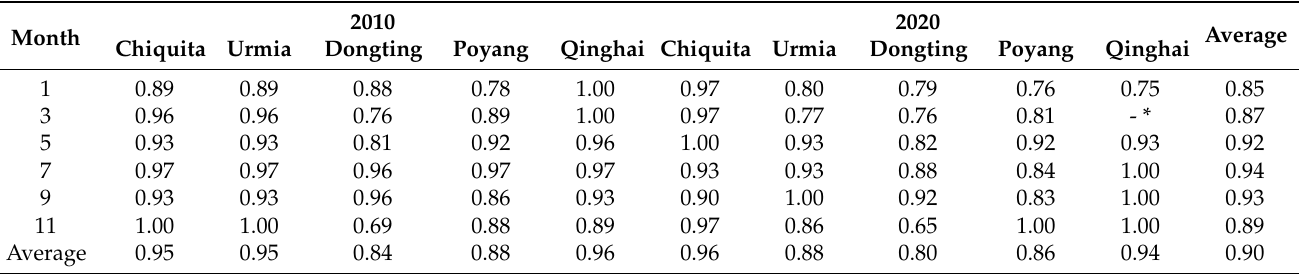
Table 3. Results of Kappa coefficients for accuracy evaluation of surface water extractions by TSIRB.